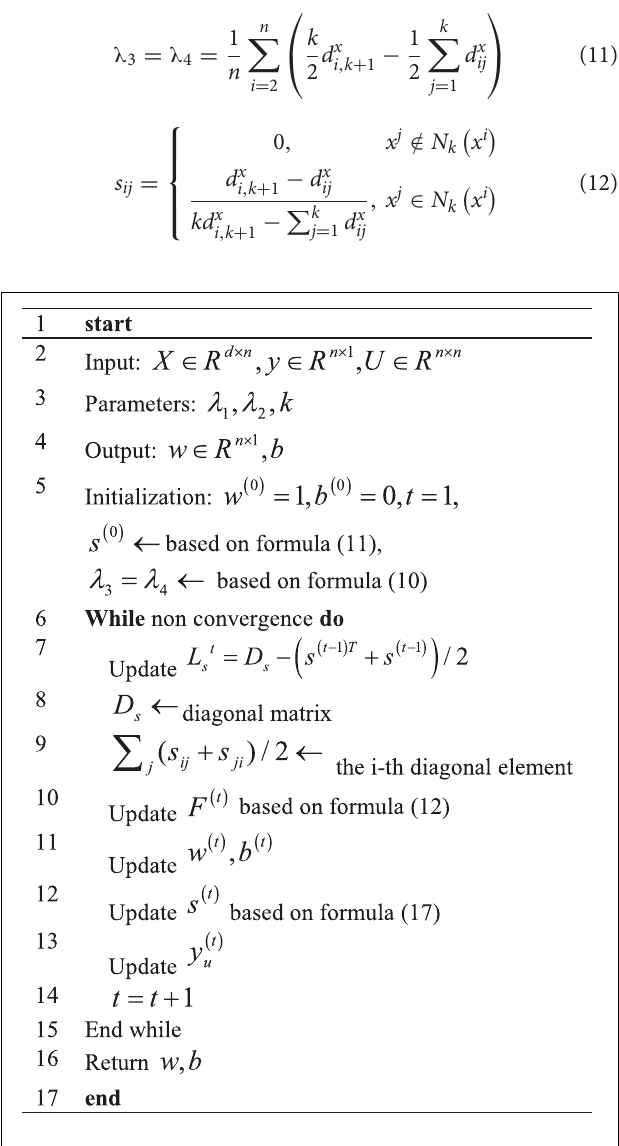
FIGURE 5 | Algorithm flow of objective function’s iterative